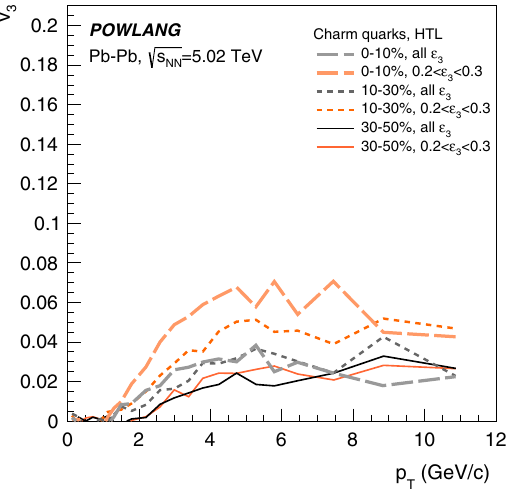
with the same (cid:7) 3 but belonging to different centrality classes display √ s NN = 5 . 02 sizabledifferences,theresponsetotheinitialeccentricitybeingstronger for more central events. The difference persists even after hadronization via